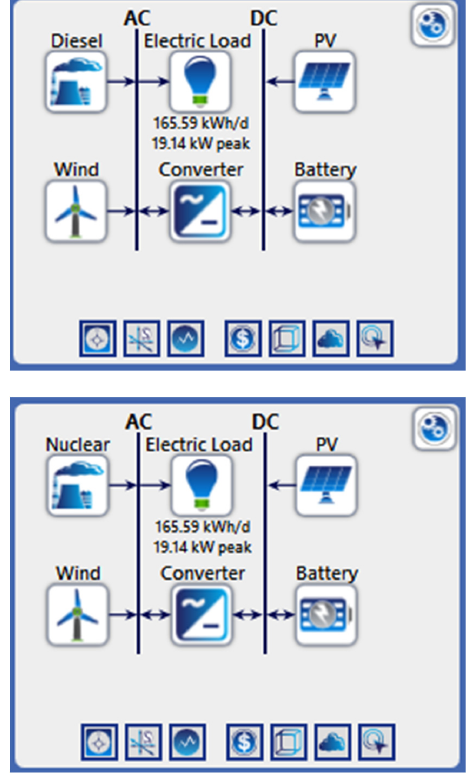
Figure 3. Distributed energy system showing the energy resource scenario 1 and 2. Table 1. Energy resource parameters.